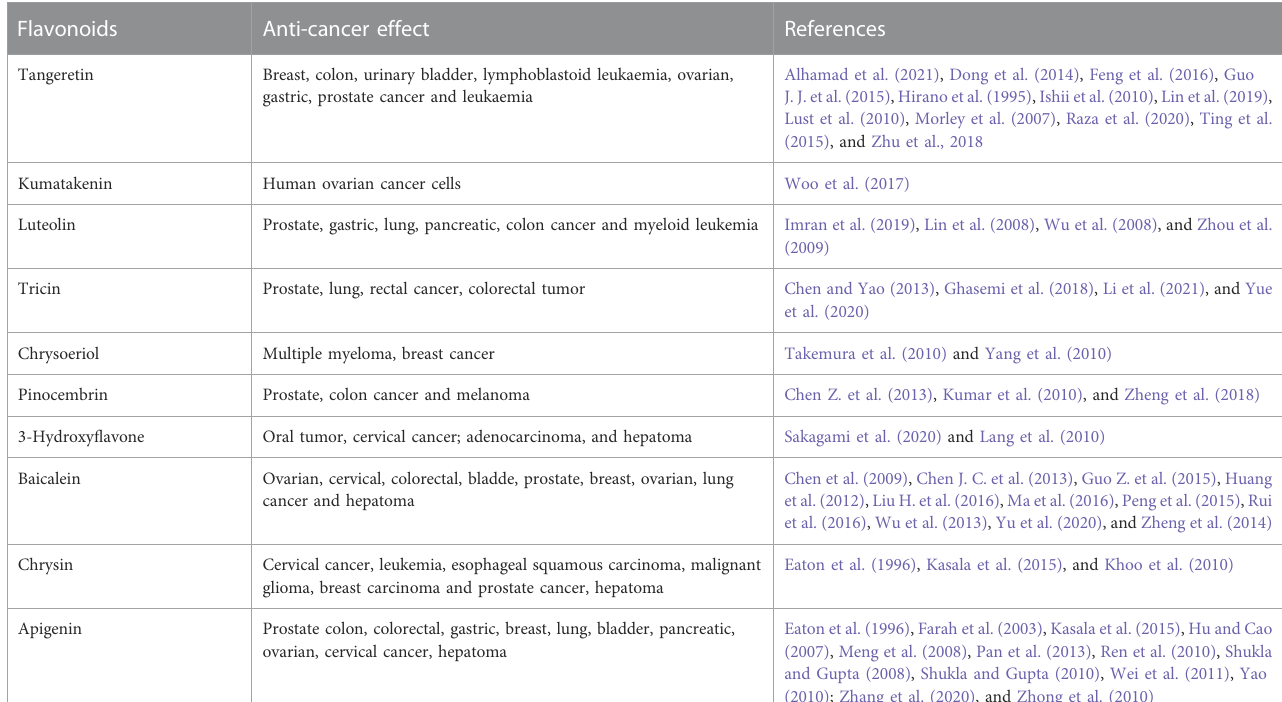
TABLE 3 Anti-cancer effect of 10 fl